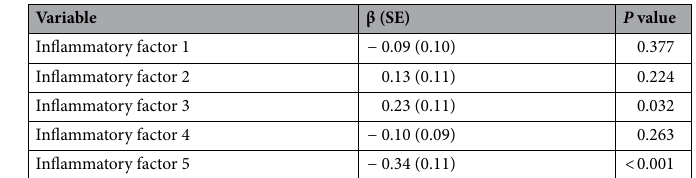
Table 3. Association between Mapuche ethnicity and inflammatory factors from exploratory factor analysis. Multiple linear regression model adjusted for age group (50–54, 55–59, 60–64, 65–69, or 70–74 years), statin use, waist circumference (in cm), diabetes, smoking status (ever or never), education (0–8, 9–12, or ≥ 13 years of schooling attained), FONASA health coverage, and diet (fresh chili and fried food consumption).